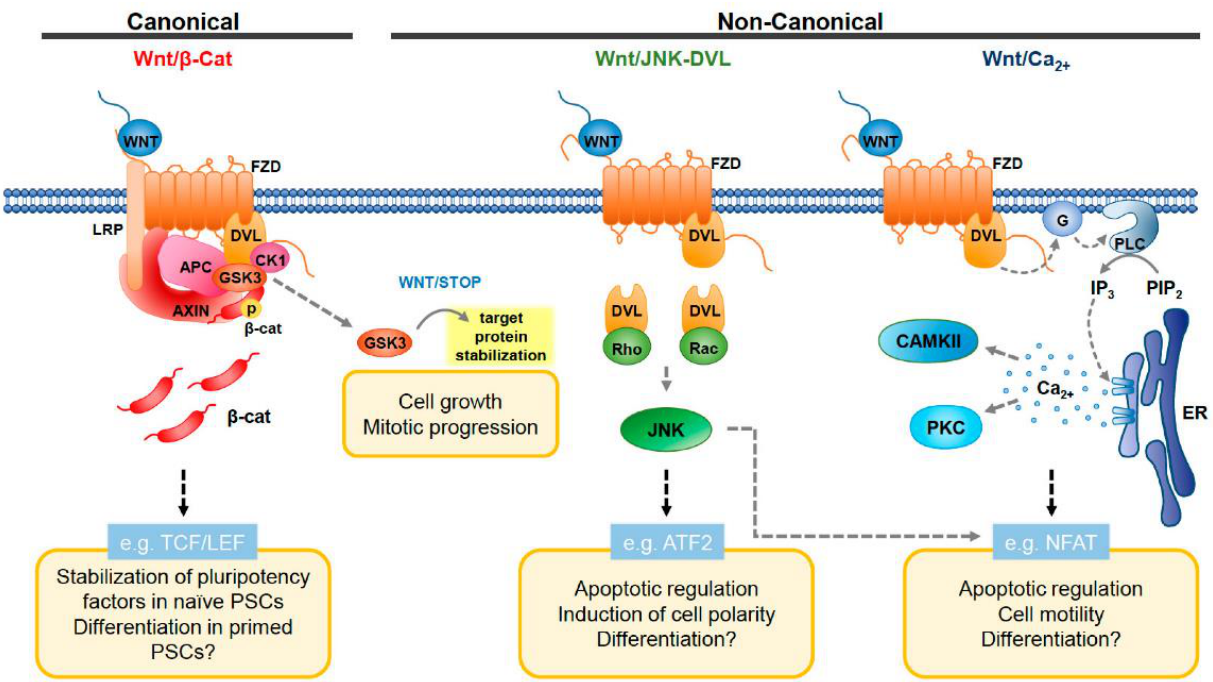
Figure 3. Canonical and non-canonical Wnt signalling. In canonical Wnt pathway, the binding of Wnt ligand and Frizzled (Fzd) receptor results in a loss of phosphorylation of β -catenin. β -catenin then migrates to the cell nucleus to trigger gene transcription. As for non-canonical JNK-DVL signalling, the reaction with the Frizzled receptor activates DVL, which then initiates the activity of Rho and Rac. As a result, JNK signalling is triggered. In calcium-dependent signalling, the reaction between the ligand and receptor is followed by the activation of the G-protein, then by elevation of intracellular Ca 2+ levels [59]. Figure replicated from [59] under Creative Commons license, provided at https://creativecommons.org/licenses/by/4.0/ (accessed on 29 January 2023). Changes have been made to the figure